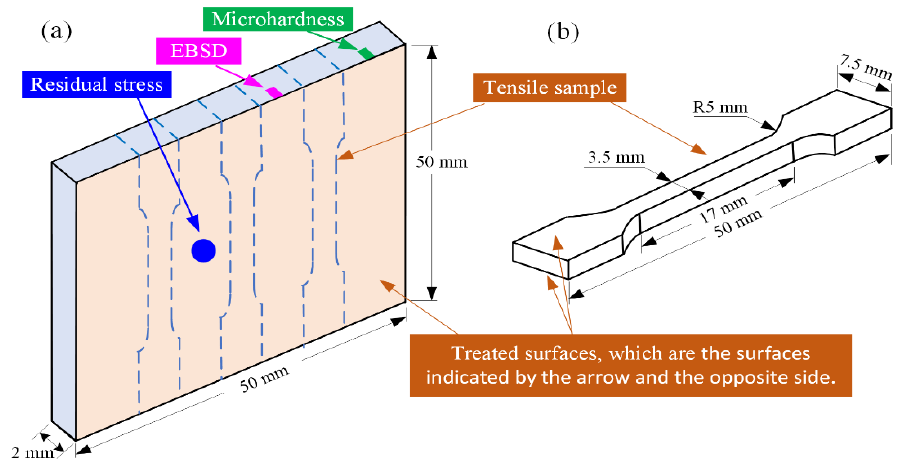
Figure 3. ( a ) Schematic of test process and ( b ) the geometrical parameters of the tensile sample.